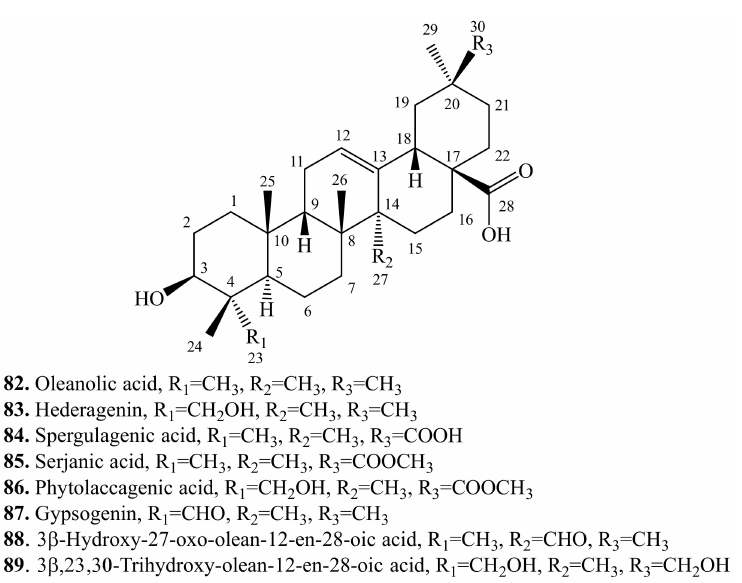
Figure 10. Structures of the main triterpenoid aglycones in quinoa.